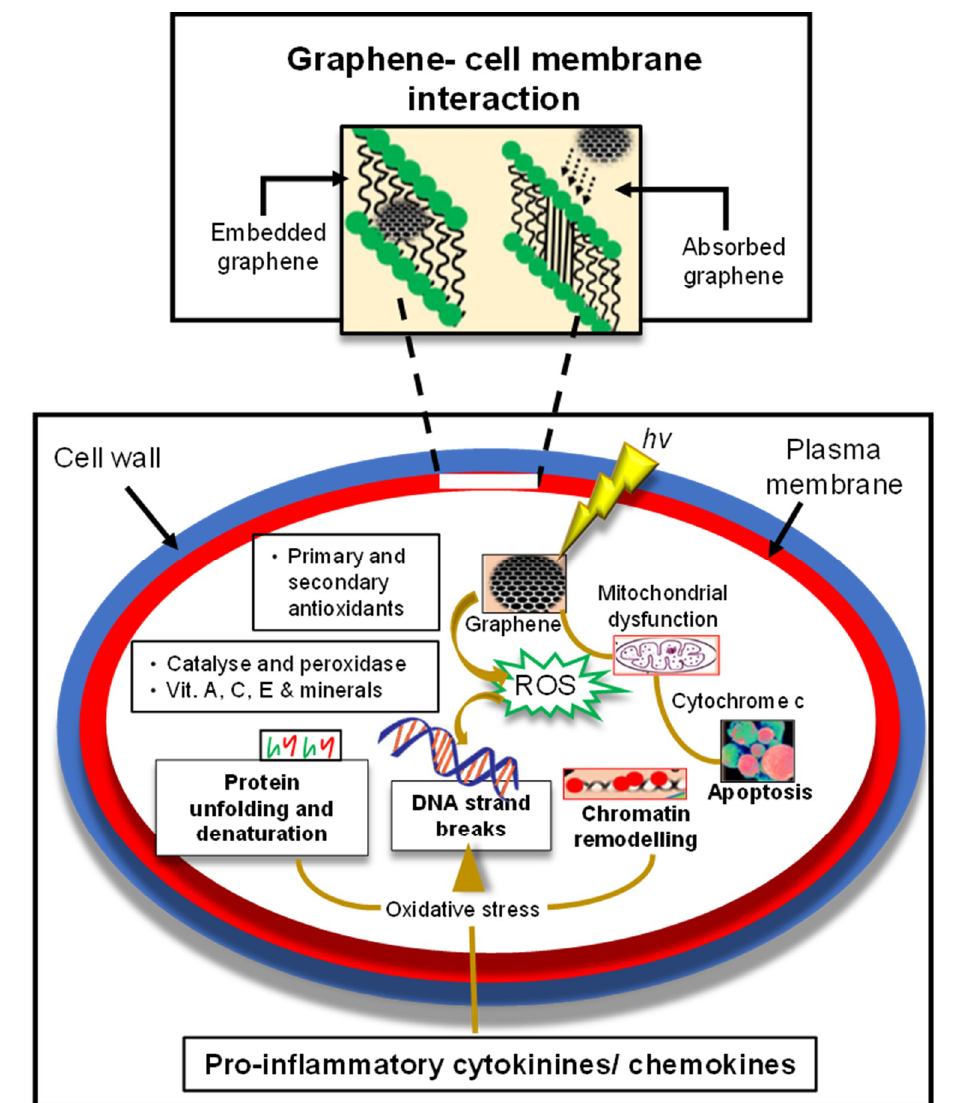
Figure 2. Schematic representation of the effective mechanisms by which ROS are linked with the toxicity of graphene at a cellular level. Adapted from [108].